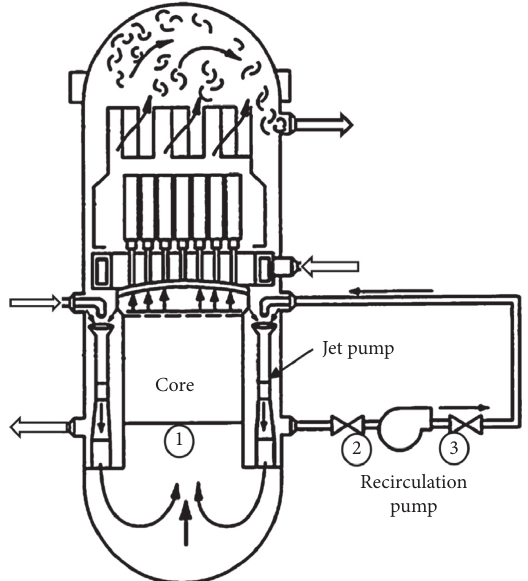
Figure 3: Zones in which the parameters reported in Table 1 take place